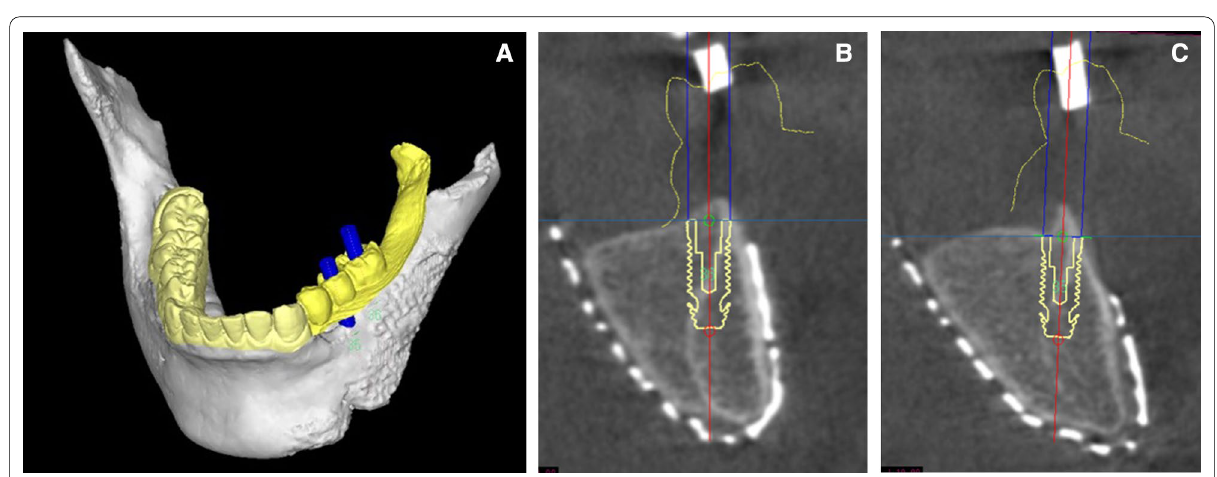
Fig. 5 Final simulation of the implant placement using cone-beam CT image ( a ) and cross-sectional data of each implant position. Simulation of 36 implant ( b ) and 37 implant ( c